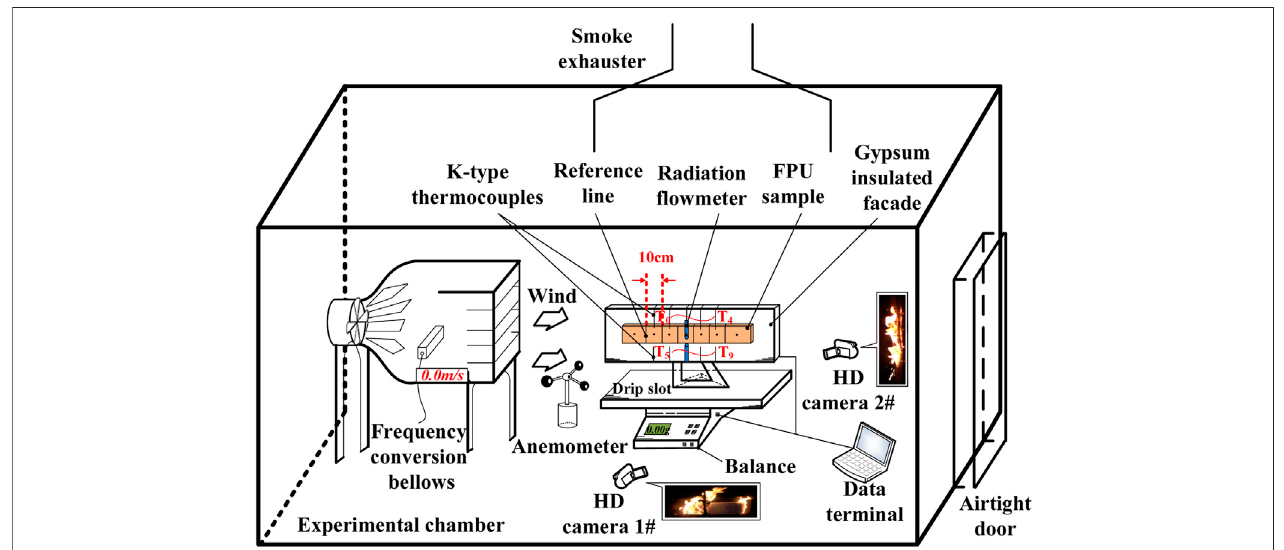
FIGURE 1 | Schematic diagram of the experimental setup for the horizontal fl ame spread of the FPU under the lateral wind.